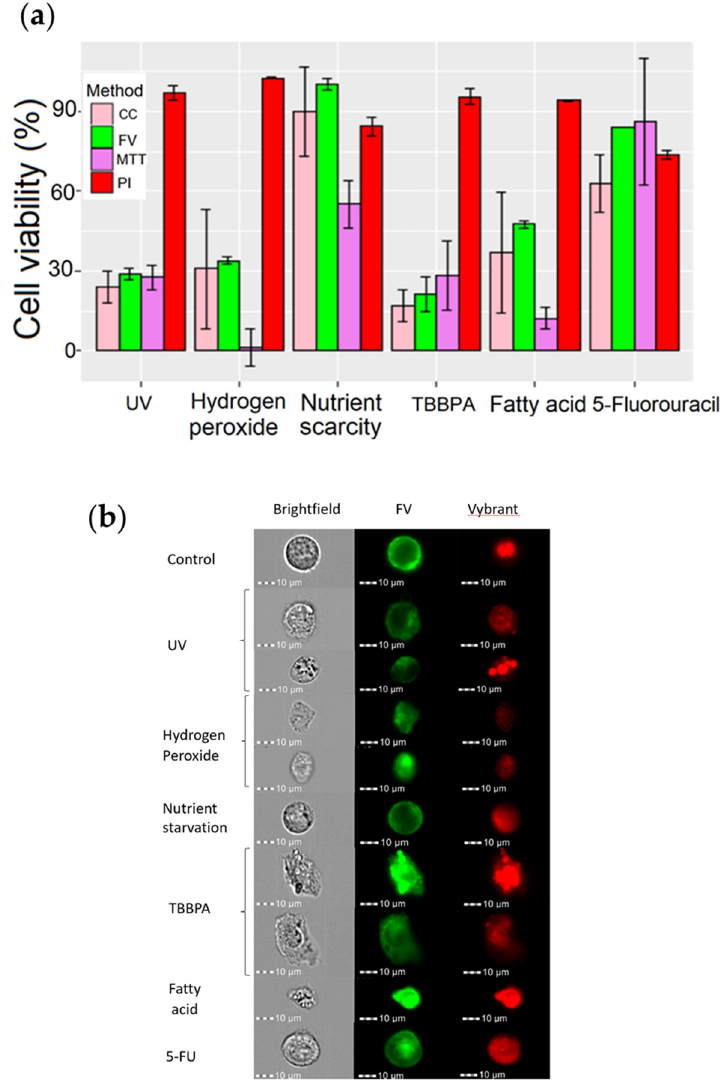
Figure 10. Assessment of cell death in TLT cells after using different toxic substances. TLT cells were treated with different toxic substances to induce programmed cell death. In the first group, cells were irradiated with UV light for 5 min. In the second group, the volume of the medium was reduced from 100 µ L to 50 µ L for 72 h. In the other groups, 5-fluorouracil, TBBPA, hydrogen peroxide, and fatty acids were added to the cell culture medium at a final concentration of 500 µ M, 266 µ M, 12.5 mM, and 2% (2/100 µ L), respectively. ( a ) Cell viability was assessed for each group and compared to controls. Viability measured via cell count method is shown with a pink bar, MPCVA with a green bar, MTT with a purple bar, and PI with a red bar. ( b ) Representative images of TLT (brightfield, FV—green, Vybrant—red) were acquired for each group during MIFC analysis.